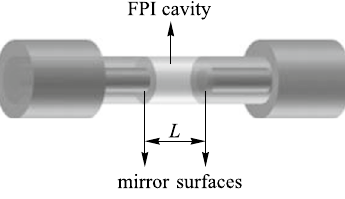
Fig. 5 Schematic diagram of the Mach–Zehnder interferometer (MZI)